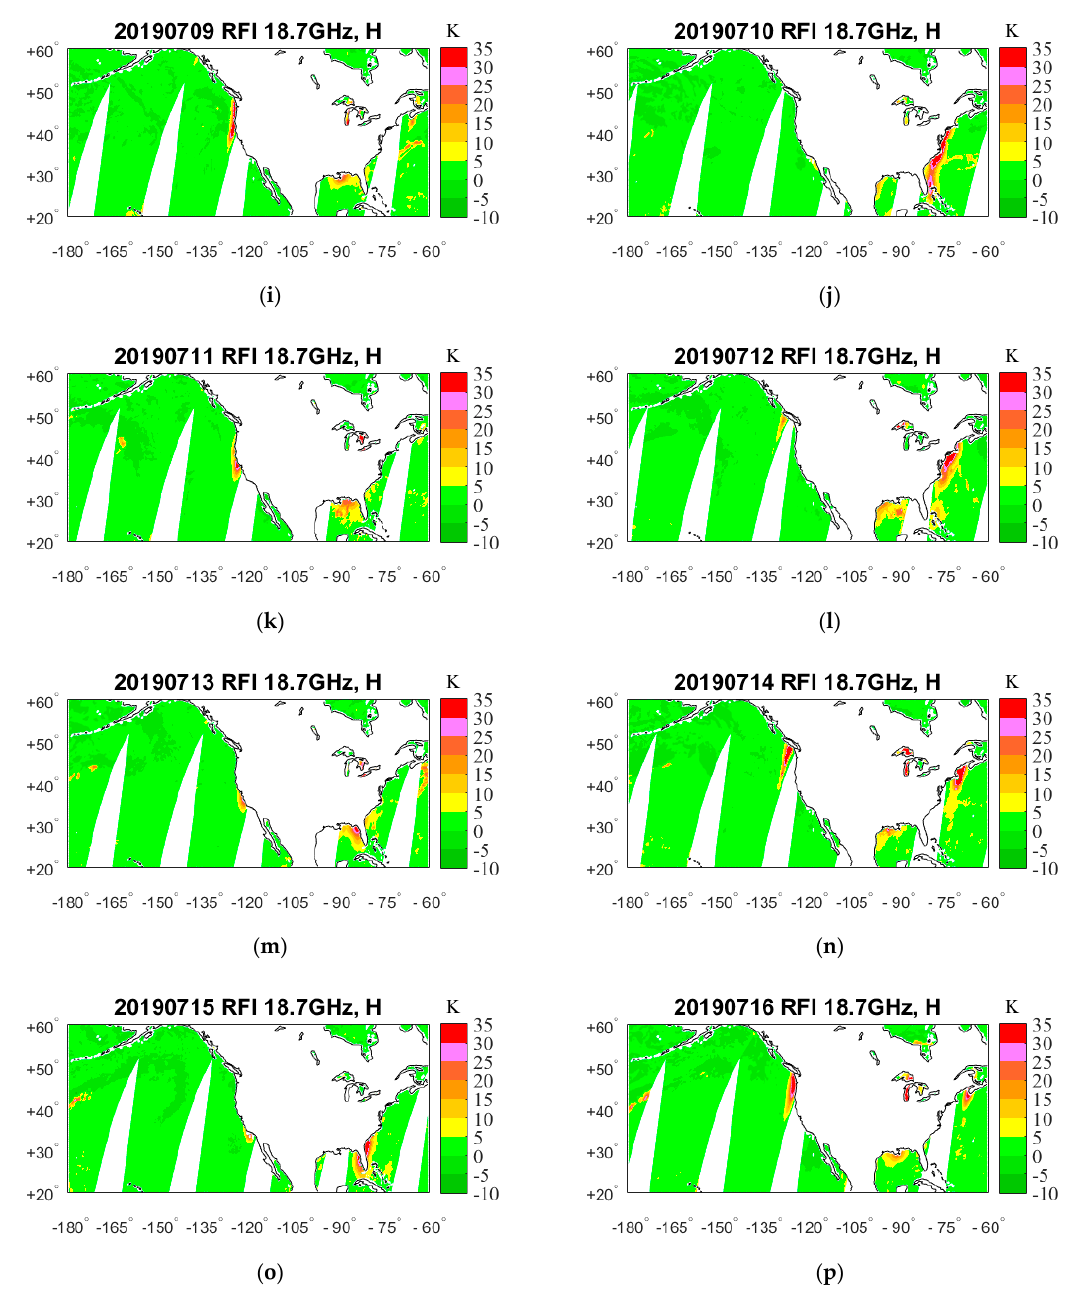
Figure 5. Spatial distribution of 18.7 GHz-H RFI, using GRDM over North American waters during the period 1–16 July 2019. ( a ) 1 July; ( b ) 2 July; ( c ) 3 July; ( d ) 4 July; ( e ) 5 July; ( f ) 6 July; ( g ) 7 July; ( h ) 8 July; ( i ) 9 July; ( j ) 10 July; ( k ) 11 July; ( l ) 12 July; ( m ) 13 July; ( n ) 14 July; ( o ) 15 July; ( p ) 16 July.